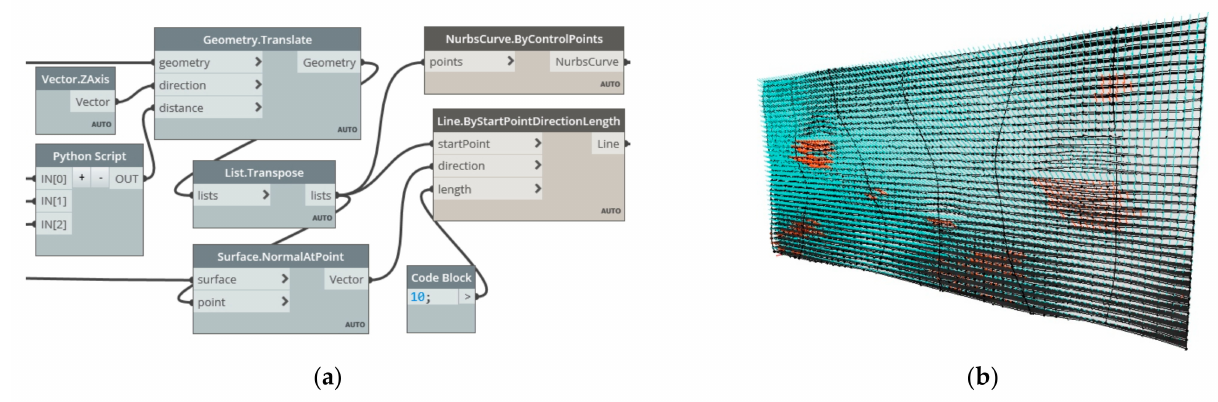
Figure 7. ( a ) Example of code blocks forming Dynamo script for generating shading elements. ( b ) Result of the shading analysis, where the blue colour represents the shaded sunlight and the red colour represents the light that passes through the gaps in the shading